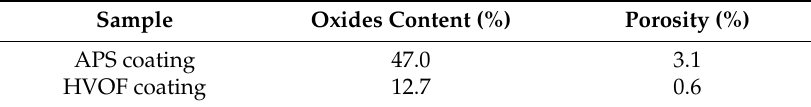
A HVOF Table 4. The oxide contents and porosity of the HEA coatings. Table 4. The oxide contents and porosity of the HEA